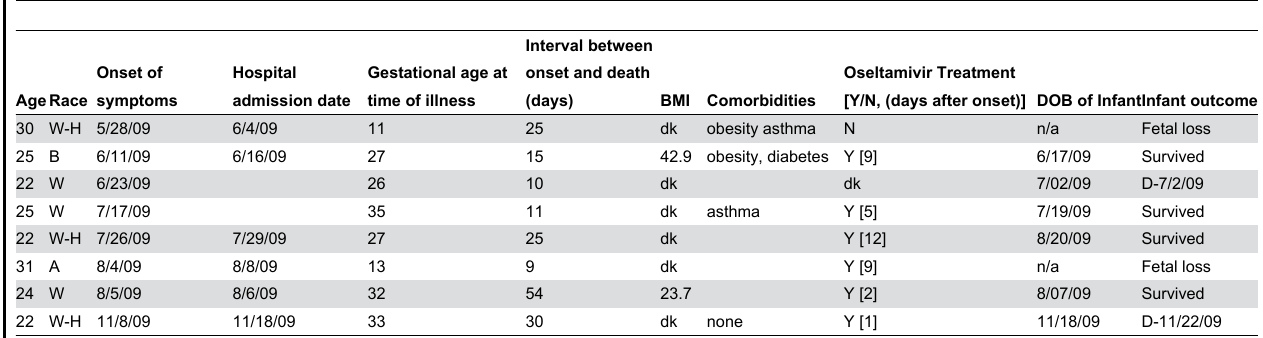
Table 6. Characteristics of maternal deaths among women with pandemic influenza illness during